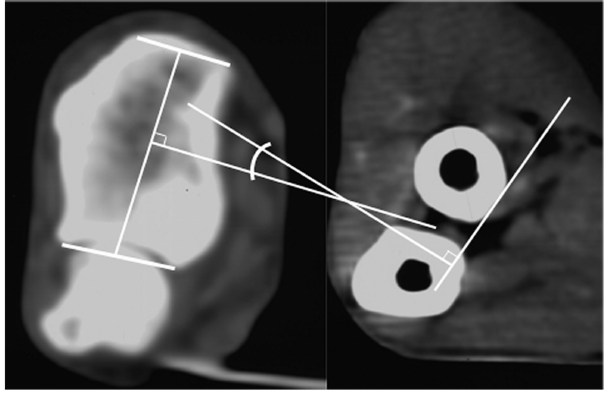
Figure 1 - Bindra et al.’s method measuring the radial torsion angle.